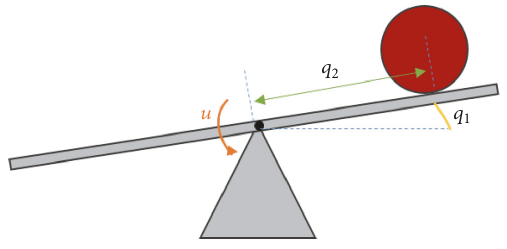
Figure 5: The beam and